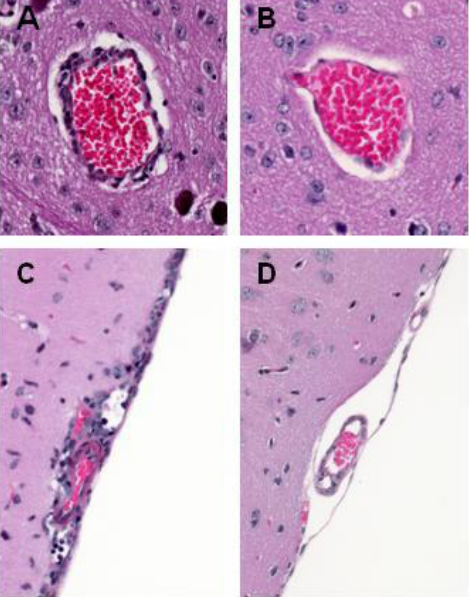
Figure 3. Representative histologic lesions in the brains of mice infected with